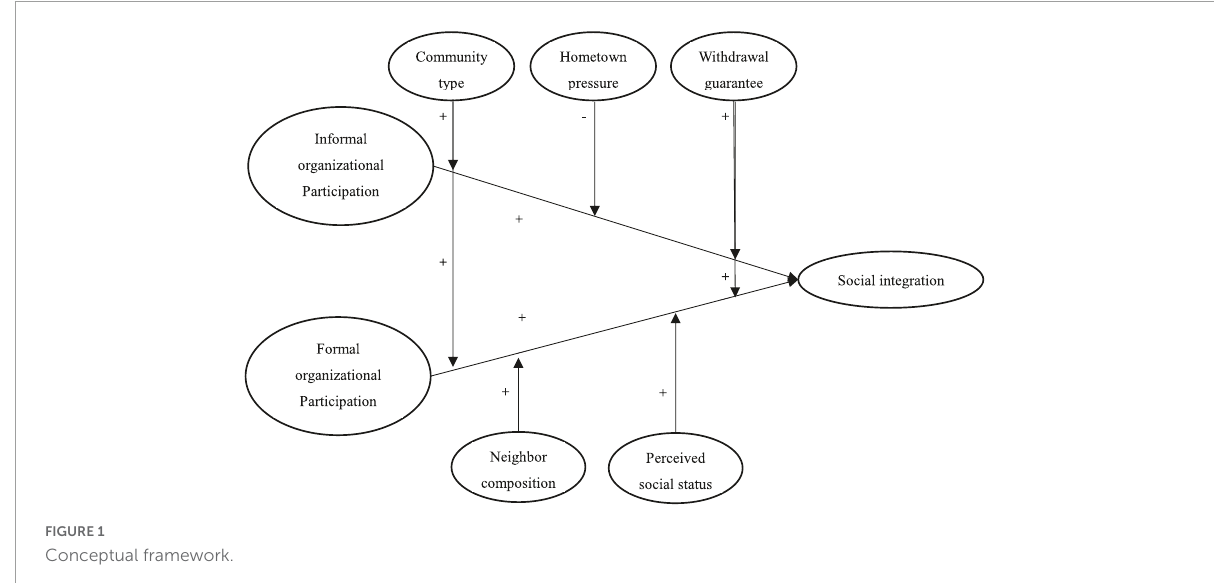
FIGURE1 Conceptual